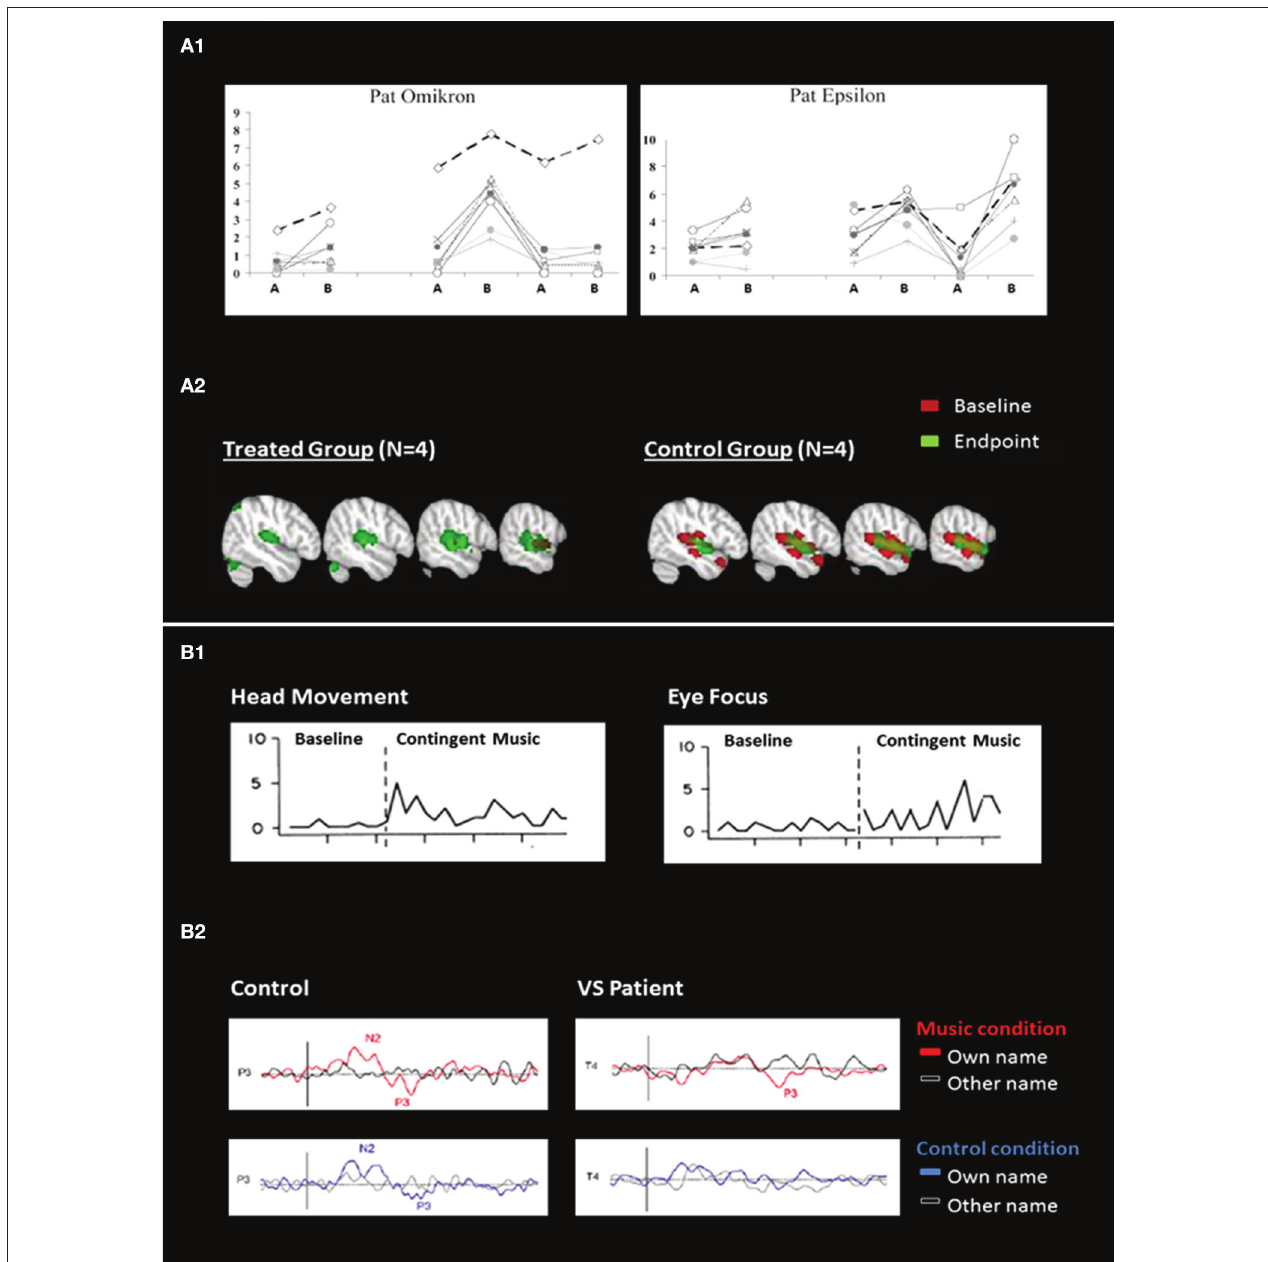
FIGURE 1 | Behavioral and neuroimaging responses to sensory stimulation (A) and music (B). (A1) Illustrates averaged behavioral scores from blinded independent raters during multimodal sensory program in two patients. The x-axis describes time (ABABAB design where A = baseline and B = treatment) and the y-axis represents the rating scores (0 = no movement, 10 = voluntary movements; adapted from Lotze et al., 2011). (A2) Illustrates brain activation in response to unimodal sensory (auditory) stimulation, at the baseline and at the end of the study (adapted from Pape et al., 2015). (B1) Illustrates behavioral responses during baseline and music stimulation for head movements and eye focus in one patient (adapted from Boyle and Greer, 1983). (B2) Illustrates event-related potentials in response to the subject’s own name and to other names in music and control conditions, in one control subject and in one patient in a vegetative state (VS) (adapted from Castro et al.,